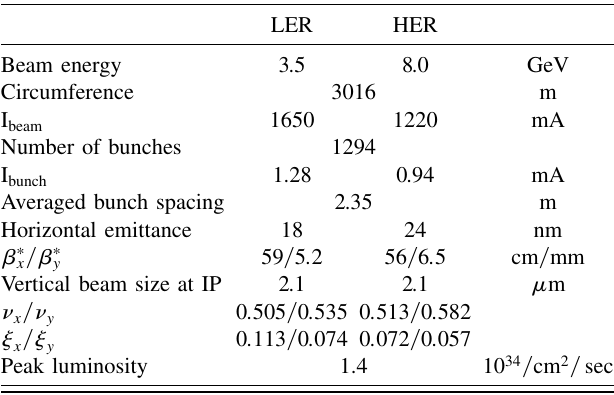
TABLE I. Machine parameters of KEKB related to the orbit feedback system.